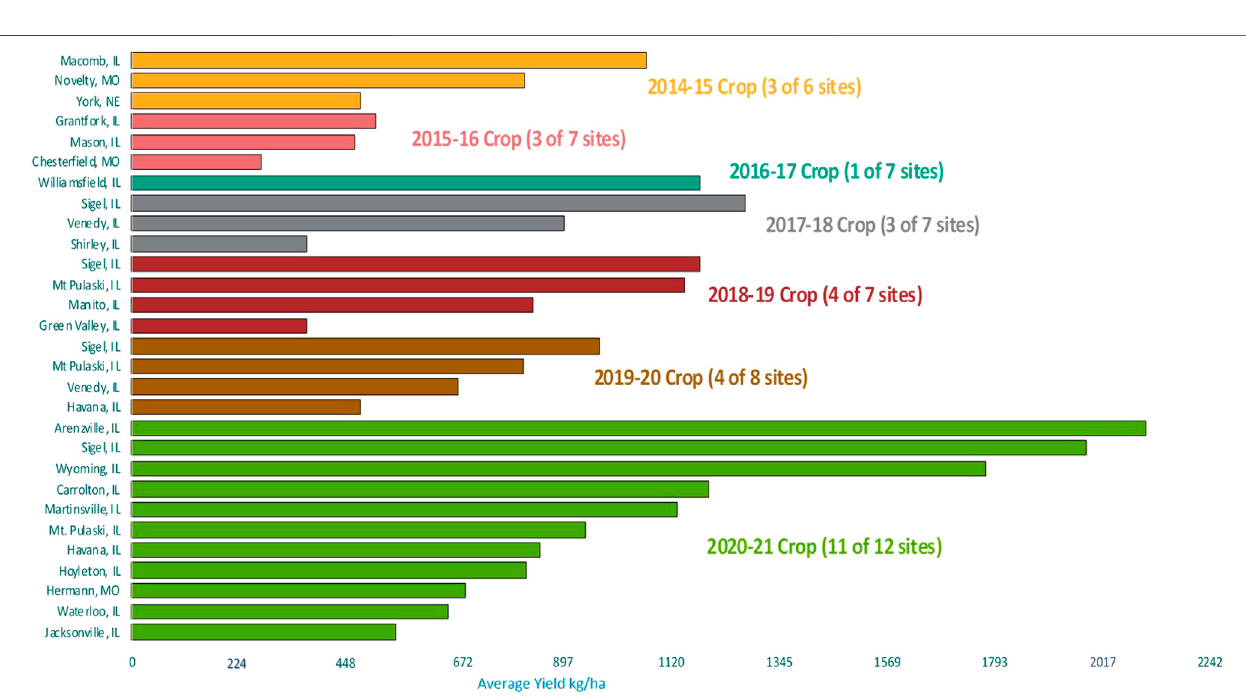
Frontiers in Energy Research |